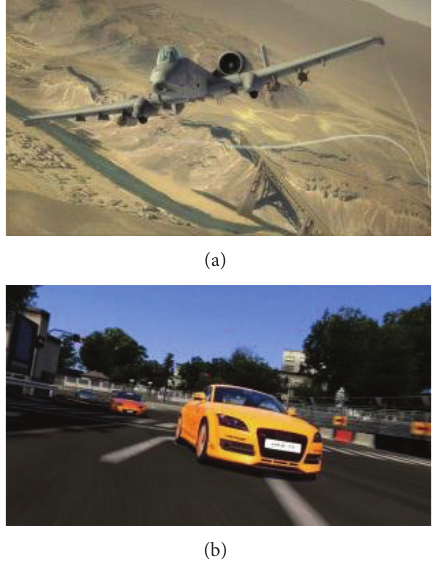
Figure 2: Two examples of modern games that aim for a high level of realism. (a) Tom Clancy’s H.A.W.X., (b) Gran Turismo